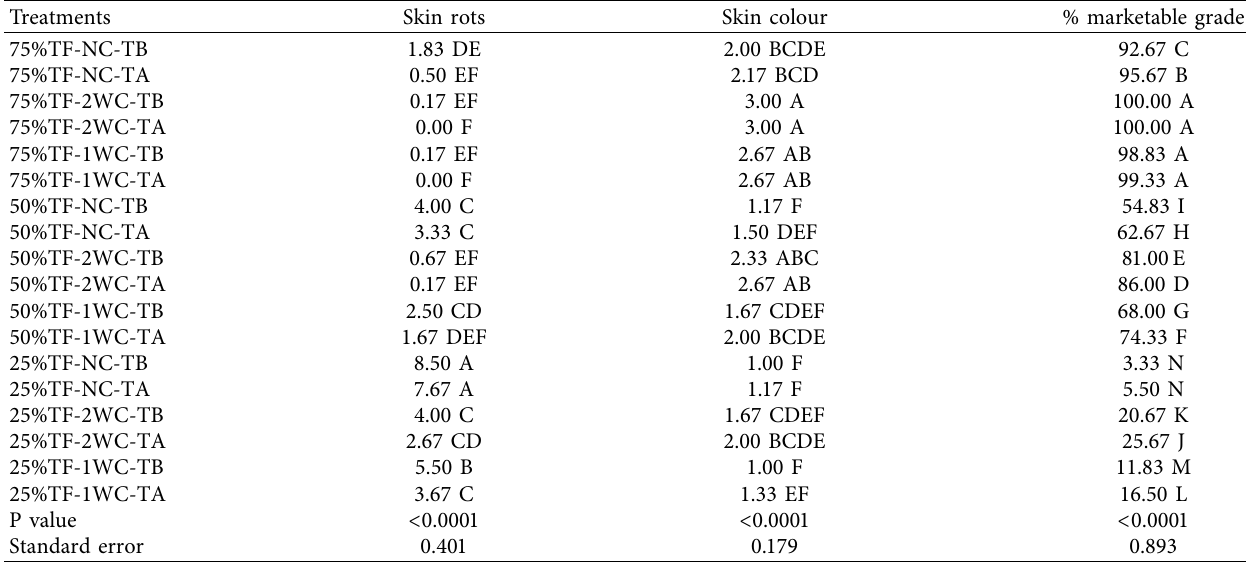
Table 5: Treatment effect on keeping quality of stored bulb onions.